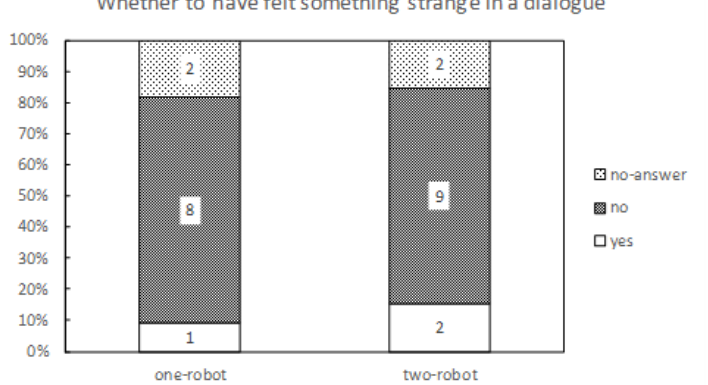
Figure 10. Results of the question to the participants in each